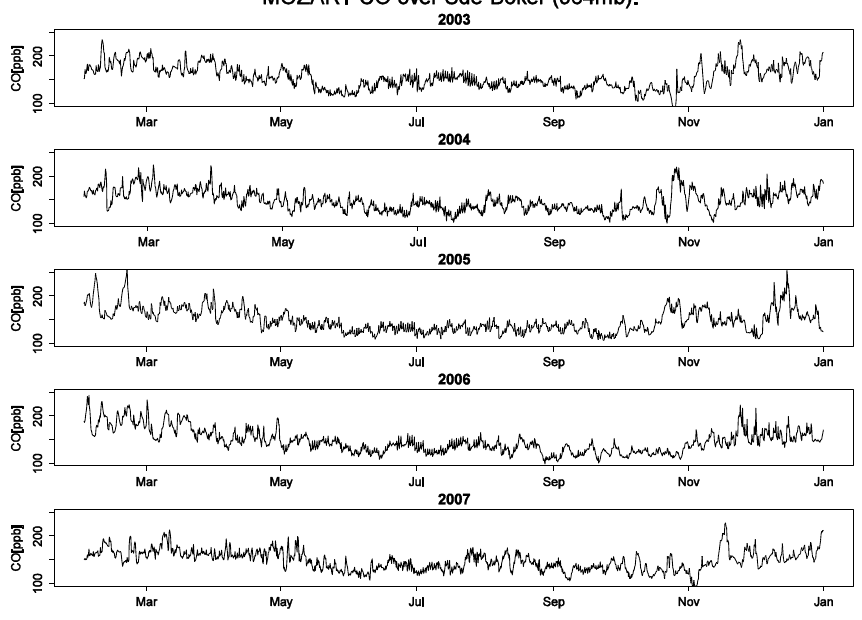
Figure 5. MOZART-4 CO surface concentration (ppb) for the study period (2003-2007). The seasonal cycle, high CO from autumn to spring and low CO during summer, is clearly seen. CO variability from autumn to spring is much higher than during summer, reflecting the synoptic system variability during these months as opposed to the stable summer conditions.